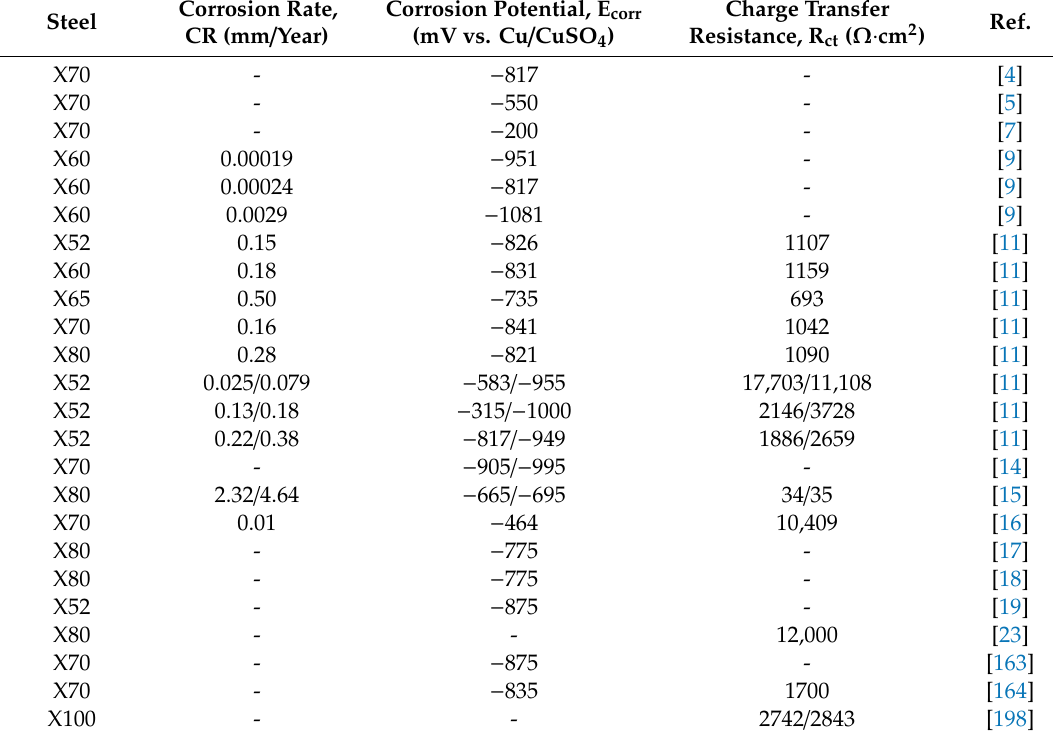
Table 5. Reviewed electrochemical properties for external corrosion